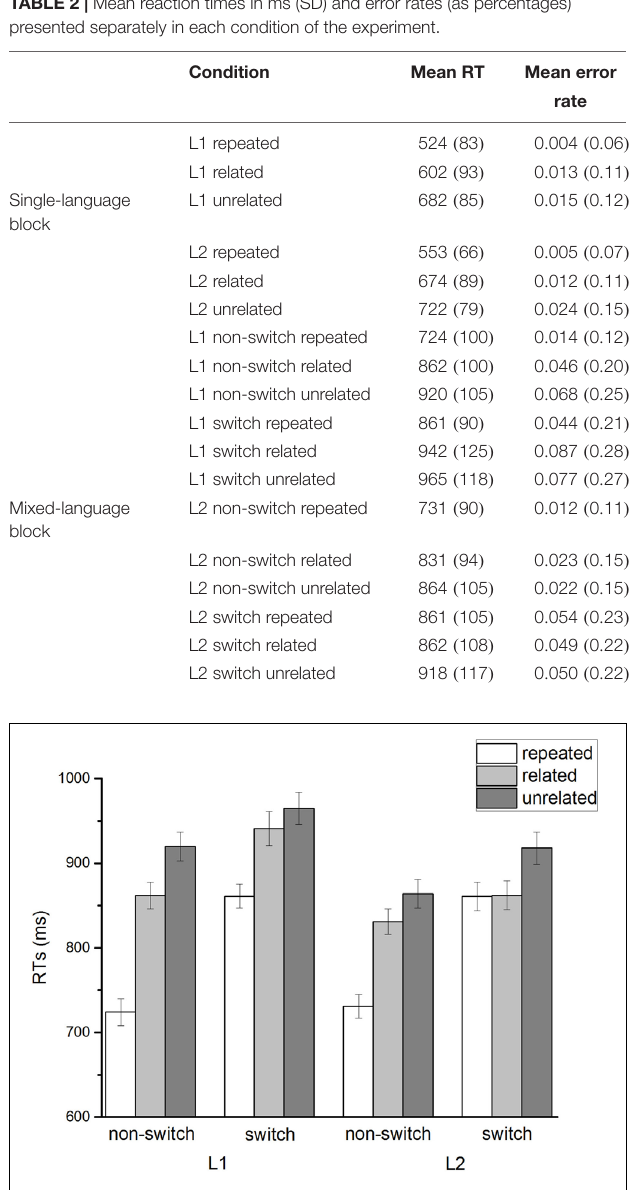
(RTs) and mean error rates in each condition (also see Figure 2